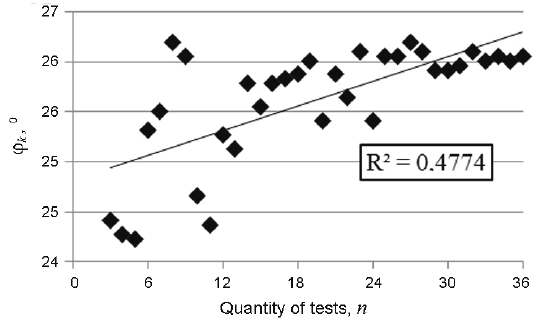
Fig. 6. The angle of internal friction versus the quantity of tests according to random data sampling